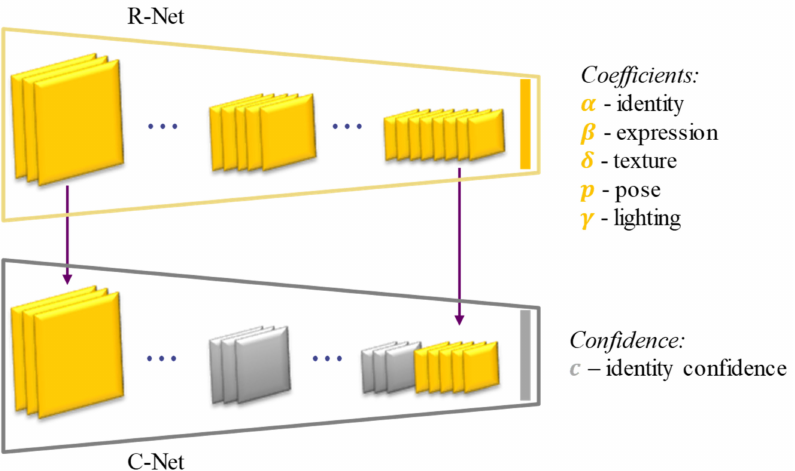
Figure 4. The network architecture for learning the parameters of the face model. The output of models, including coefficients that represent identity ( α ), expression ( β ), texture ( δ ), pose ( p ), lighting ( γ ), and identity confidence ( c